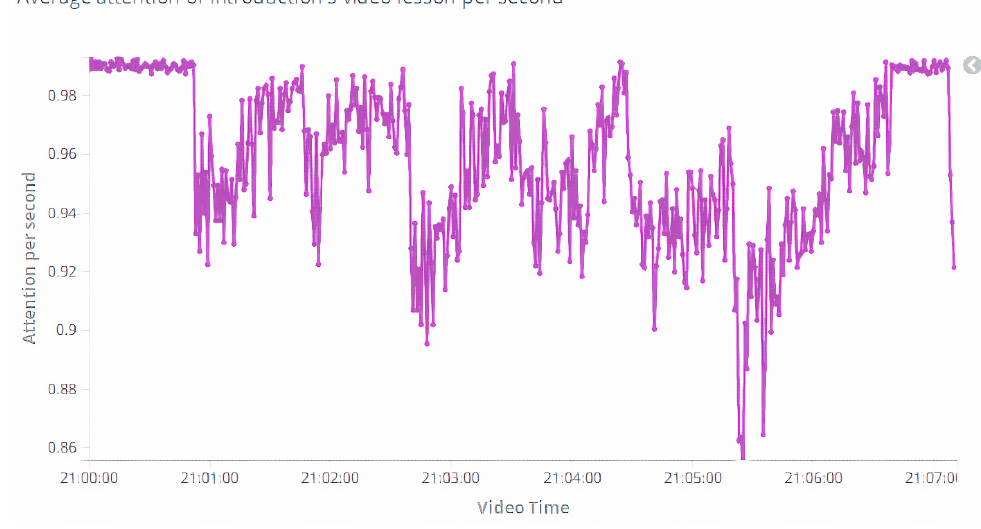
Figure 5. Average attention of students for a certain lesson.